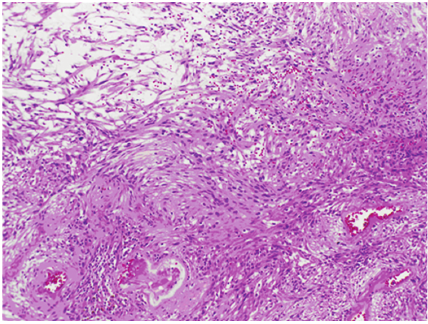
Figure 2: Schwannoma characterized by Antoni A and Antoni B architecture (hematoxylin and eosin ×